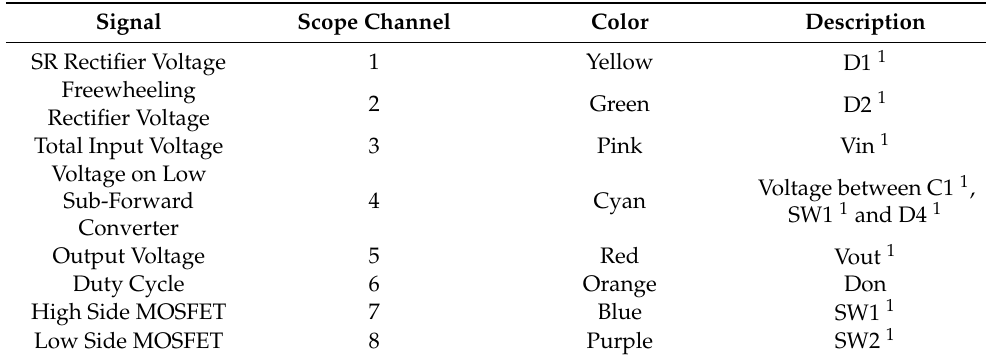
Figure 14. High line maximum voltage (265 V) DVFW simulation ( top left ) and measure- ment ( bottom left ) vs. conventional forward converter simulation ( top right ) and measurement ( bottom right ). Table 4. Figures 13 and 14 waveforms